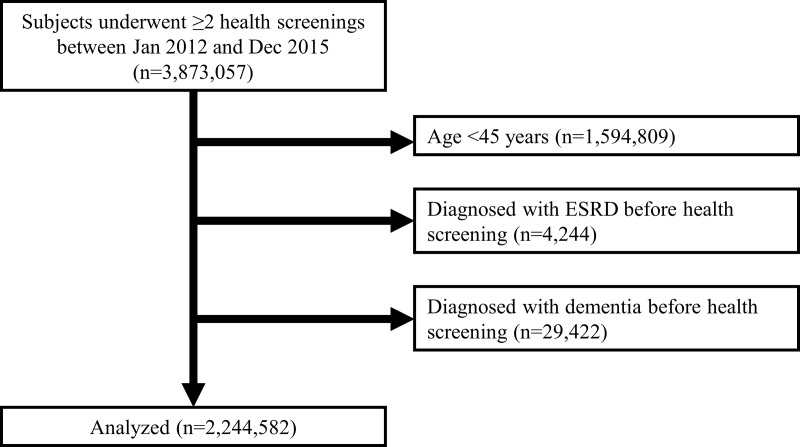
Diagram showing the study population.